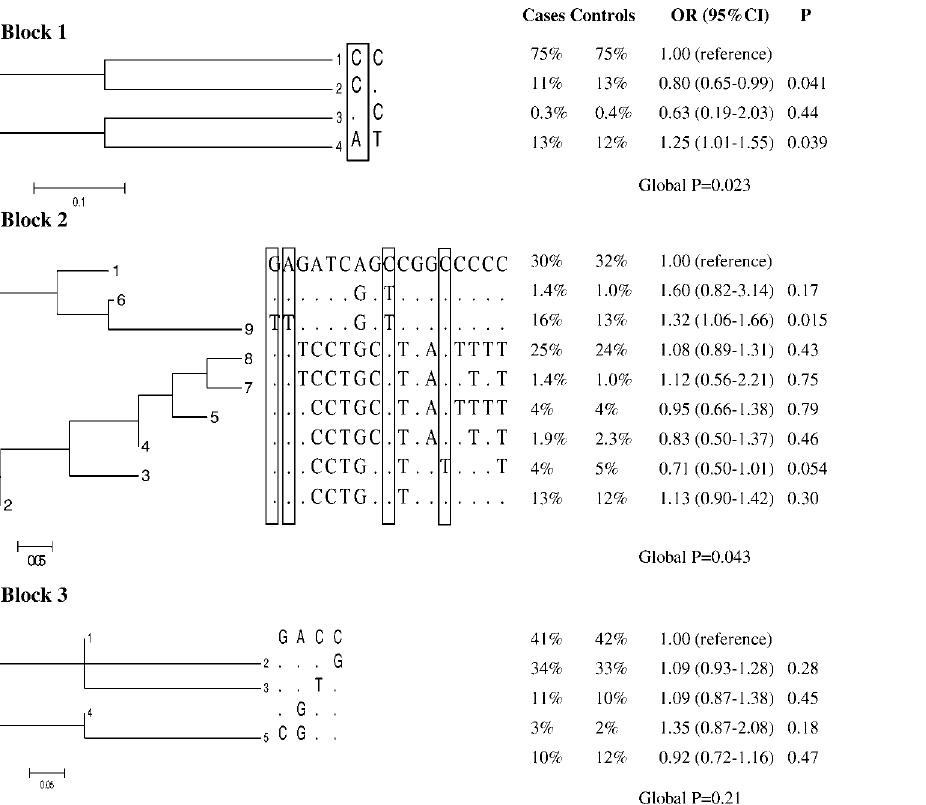
Figure 2. Phylogenetic Trees for VEGF Haplotypes and Association with Bladder Cancer Risk among 926 Cases and 900 Controls with DNA in the iPLEX Assay, Spanish Bladder Cancer Study See Figure 1 for block definitions. Of the 29 VEGF SNPs determined, two had low genotypic variation in our population; therefore, haplotype analyses were based on the remaining 27 SNPs. Polymorphic bases are in 5 9 to 3 9 order: Block 1( rs833052 and rs866236); Block 2 ( rs1109324 , rs1547651 , rs833060, rs699947, rs1005230, rs833061, rs1570360, rs2010963, rs25648 , rs833067, rs3025042, rs833068, rs3024994 , rs735286, rs3024998, rs3025000, and rs3025006); and Block 3 (rs3025030, rs3025033, rs3025035, and rs3025036). Bolded rs numbers are for individual SNPs significantly associated with bladder cancer risk. Eleven cases and 13 controls with missing data on more than 15 of the 17 SNPs in Block 2 were excluded from haplotype analyses because their inclusion resulted in lack of convergence. Nucleotide changes significantly associated with risk in the individual genotype analyses are shown in boxes. The most common haplotye is the reference category. Haplotypes with the common variant for each individual SNP are CC for Block 1, GAGCCGTGCTGGCCCCC for Block 2, and GACC for Block